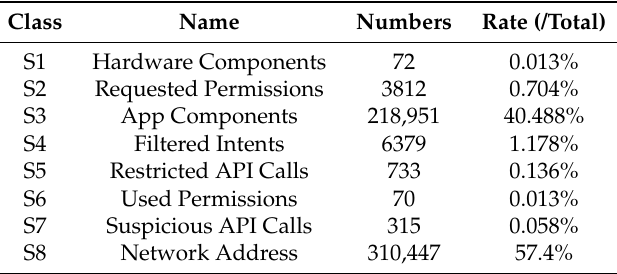
Table 2. Eight features in the DREBIN